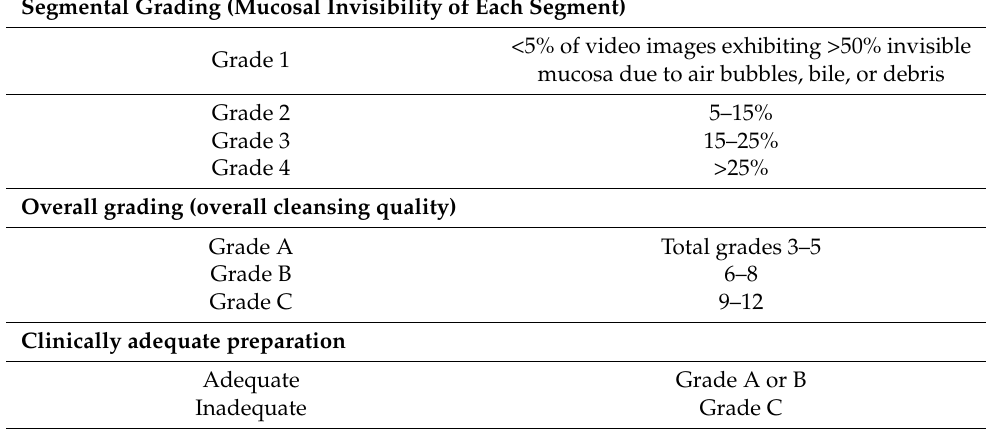
Table 1. Validated small bowel preparation scale using a quantitative